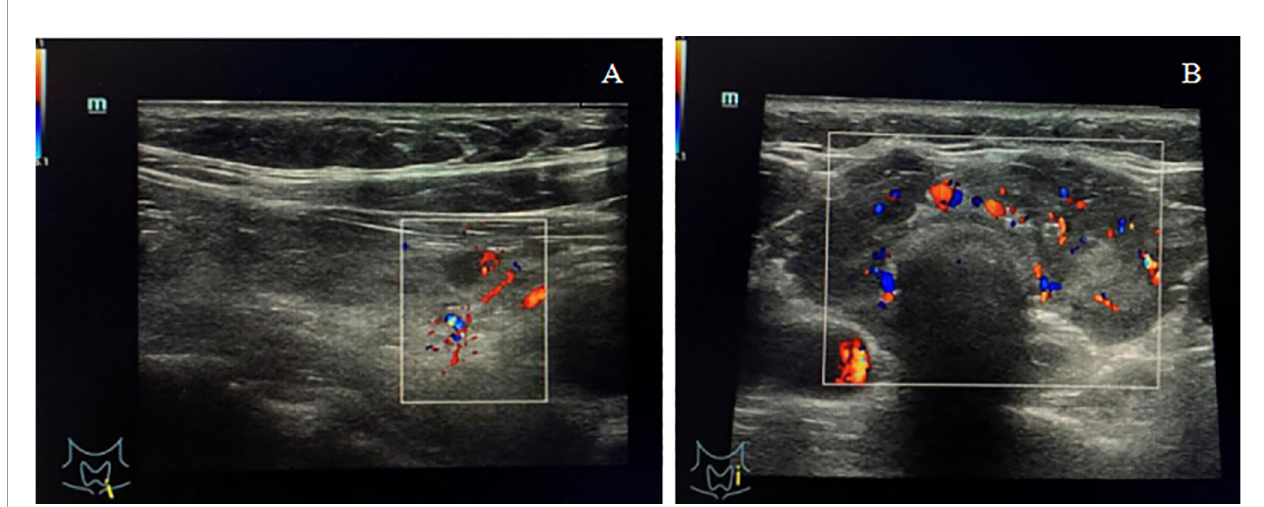
FIGURE 1 | (A) Ultrasonography showed bilateral thyroid reduction and multiple nodules (<0.5 cm in diameter) in the left lobe with normal blood fl ow signals. (B) Ultrasonography showed thyroid enlargement with diffuse reduction in gland echo and abundant blood fl ow